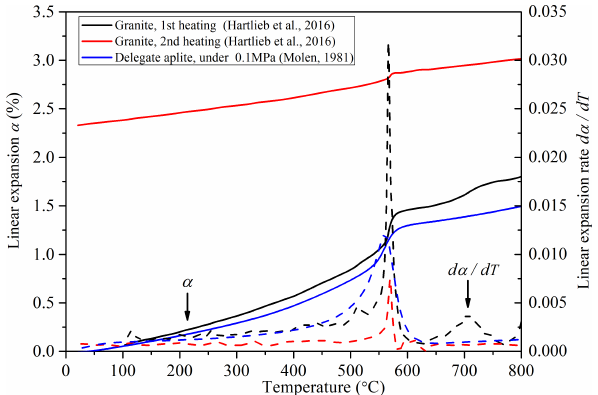
Figure 6: Linear expansion ( α ) (solid line) and rate of linear expan- sion ( α ) change, d α / dT , (dotted line), versus elevated temperature